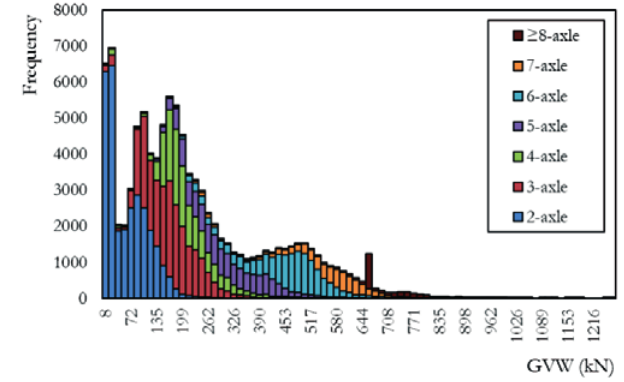
Vehicles histogram, based on number of axles, that traveled over Lambari